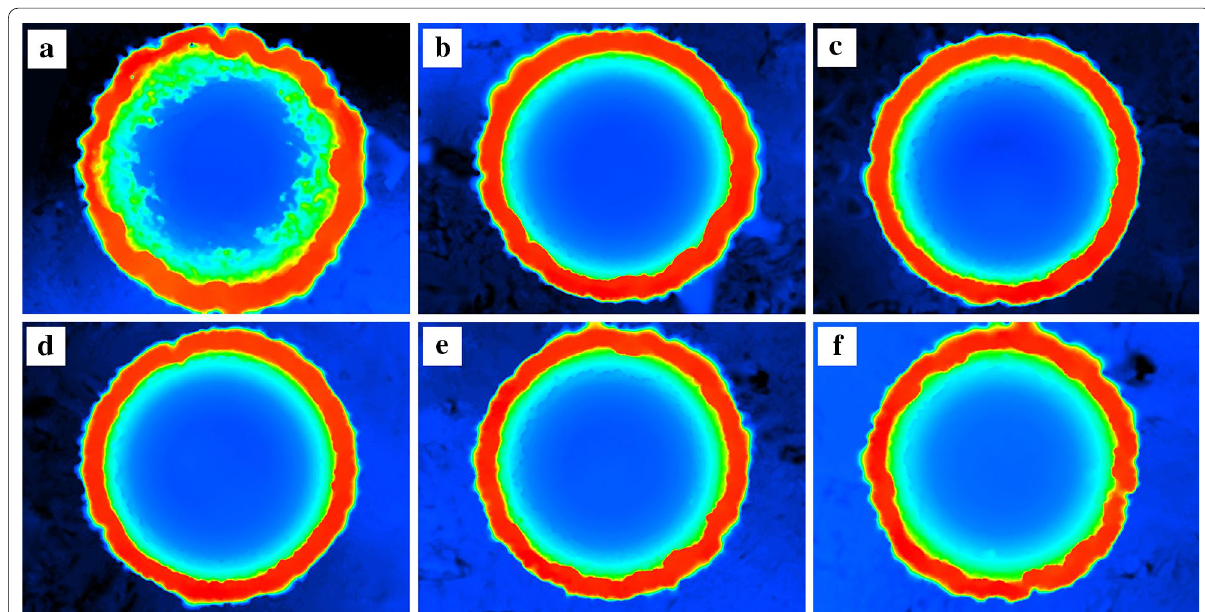
Figure 9 Height profiles of the drawn cups measured by laser microscope with annealed specimens: a A700, b A850, c A900, d A950, e A1000, f A1100